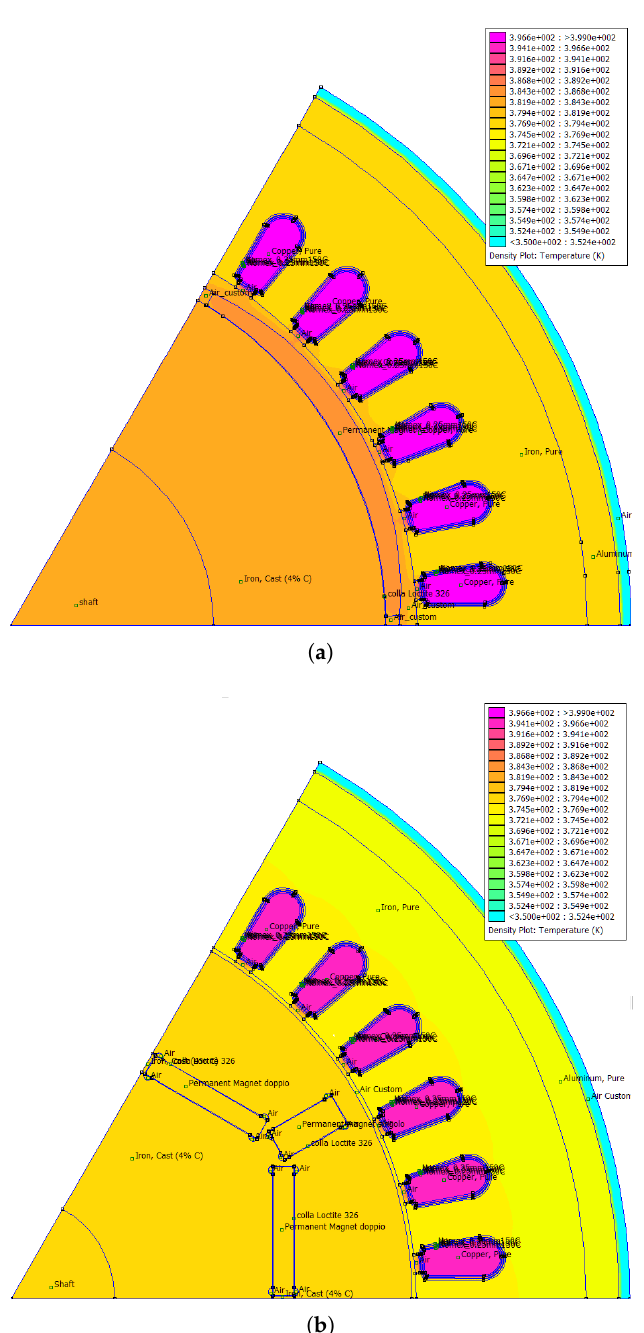
Figure 11. Steady-state thermal FEA with sinusoidal currents from 350 K to around 400 K: ( a ) reference SPM; ( b ) proposed